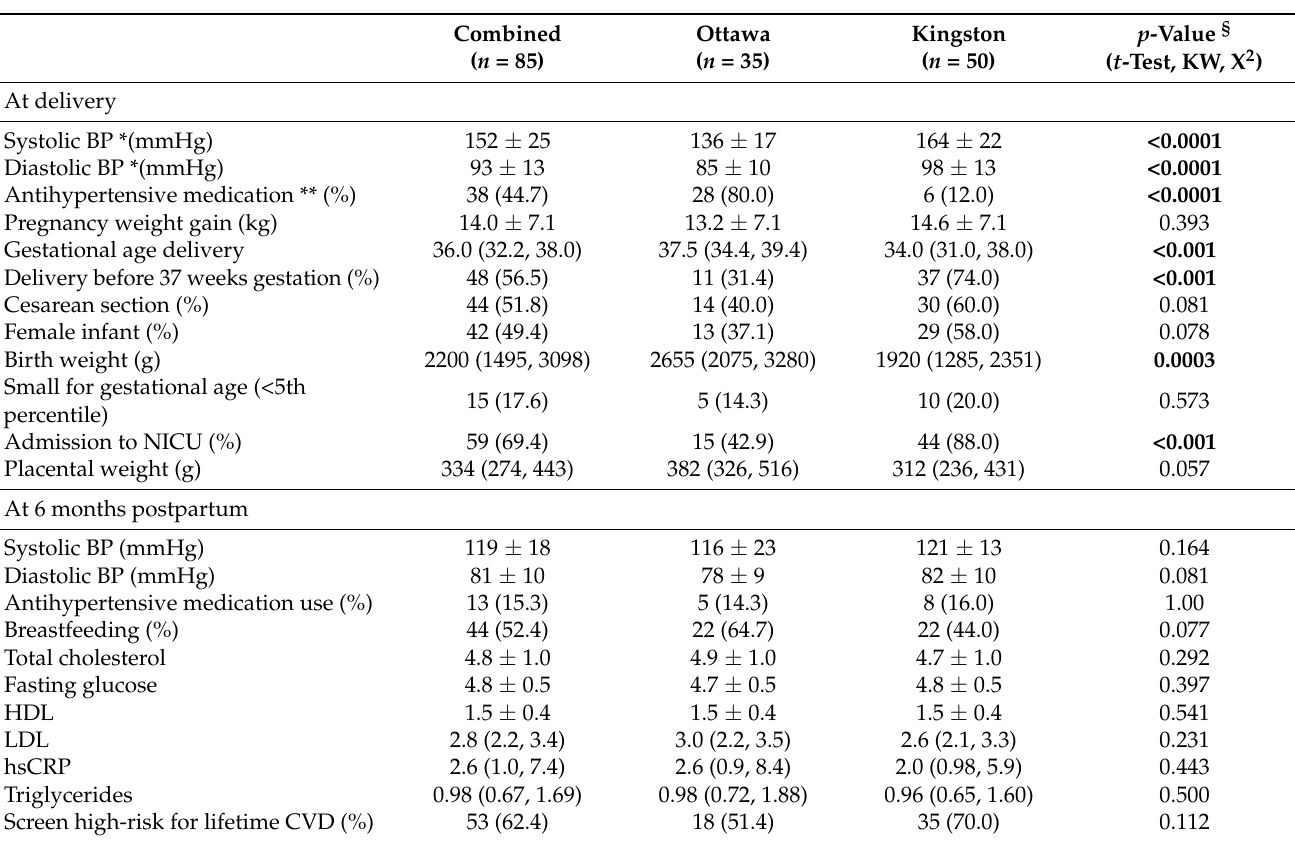
Table 2. Delivery and postpartum characteristics of the study participants as a combined cohort and by individual study